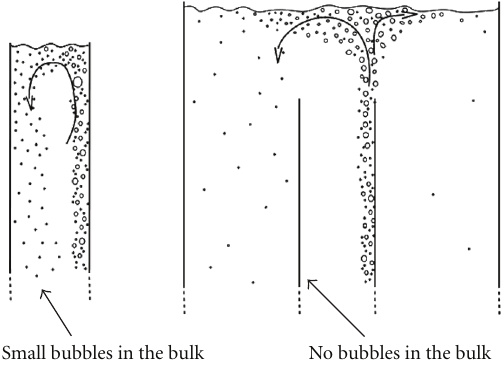
Figure 7: Schematic recirculation of small bubbles in single-channel (left) and multichannel (right)